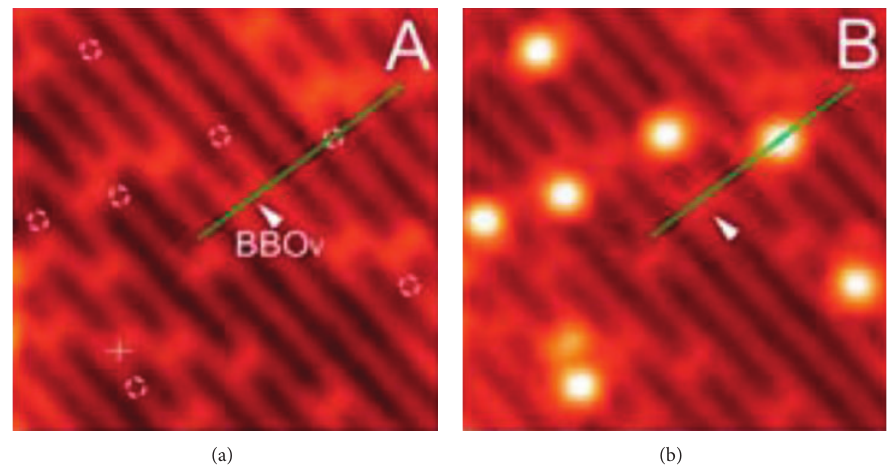
Figure 14: STM images of the methanol molecules and oxygen vacancies distribution on TiO 2 surface. (a) Before methanol exposure, BBOv represents the bonding bridging oxygen in the shallow bright color. (b) After methanol exposure, the strong bright dots reveal the methanol adsorption sites